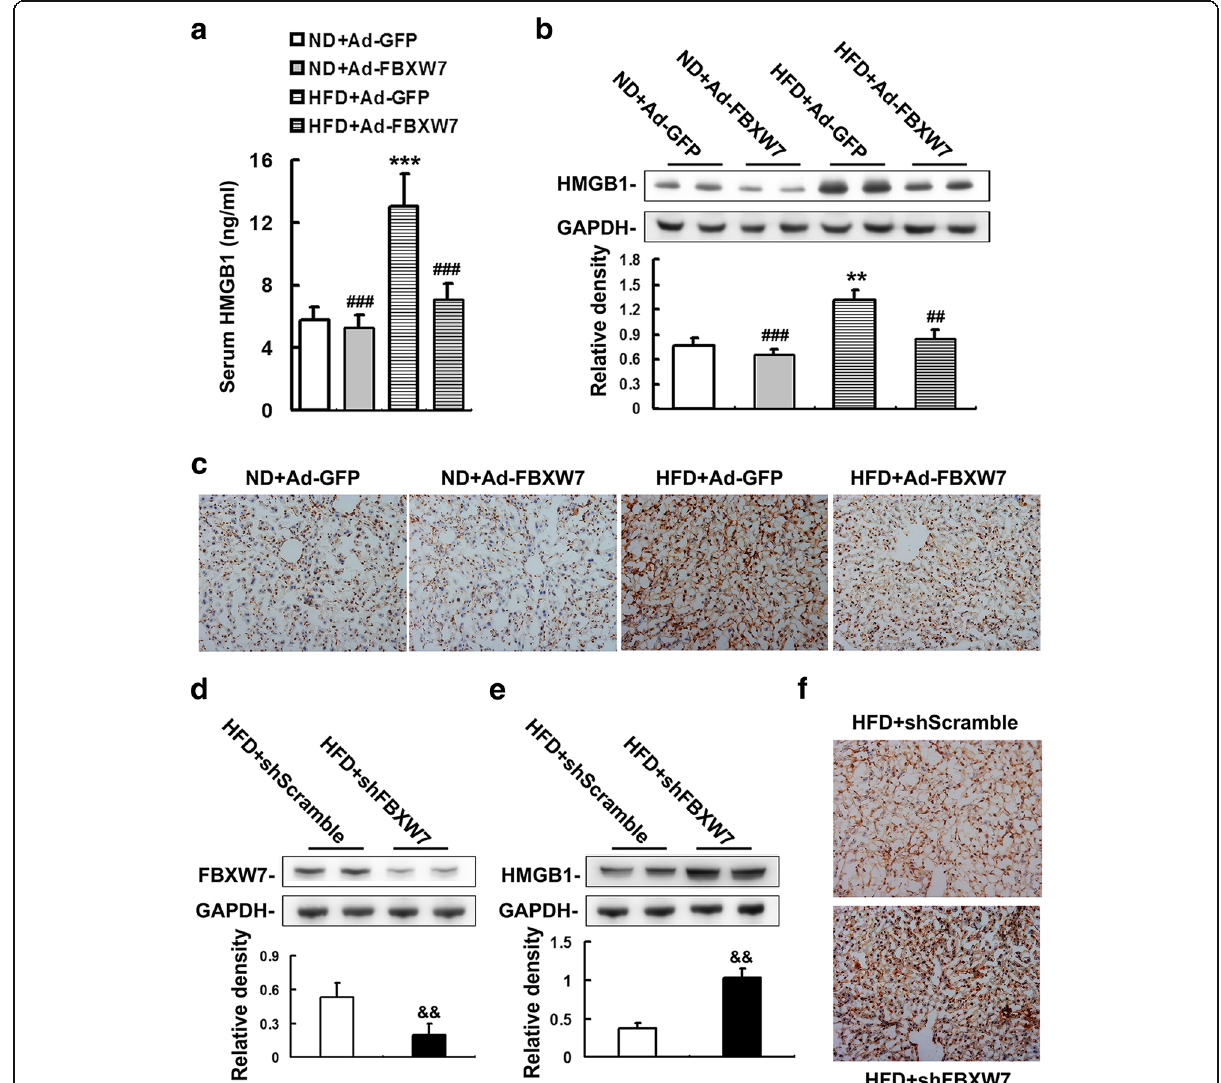
Fig. 4 FBXW7 suppresses the expression and release of HMGB1 in HFD-fed mouse livers. a Serum HMGB1 levels in different treatment groups ( n = 5). b and ( e ) Immunoblotting and densitometry of HMGB1 in mouse livers ( n = 4). c and ( f ) Immunohistochemistry staining of HMGB1 in mouse livers ( n = 4). d Immunoblotting and densitometry of FBXW7 in mouse livers ( n = 4). Magnification 200X. All of the values are expressed as the mean ± SD. ** P < 0.01, *** P < 0.001 versus the ND + Ad-GFP group; ## P < 0.01, ### P < 0.001 versus the HFD + Ad-GFP group; && P < 0.01 versus the HFD + shScramble